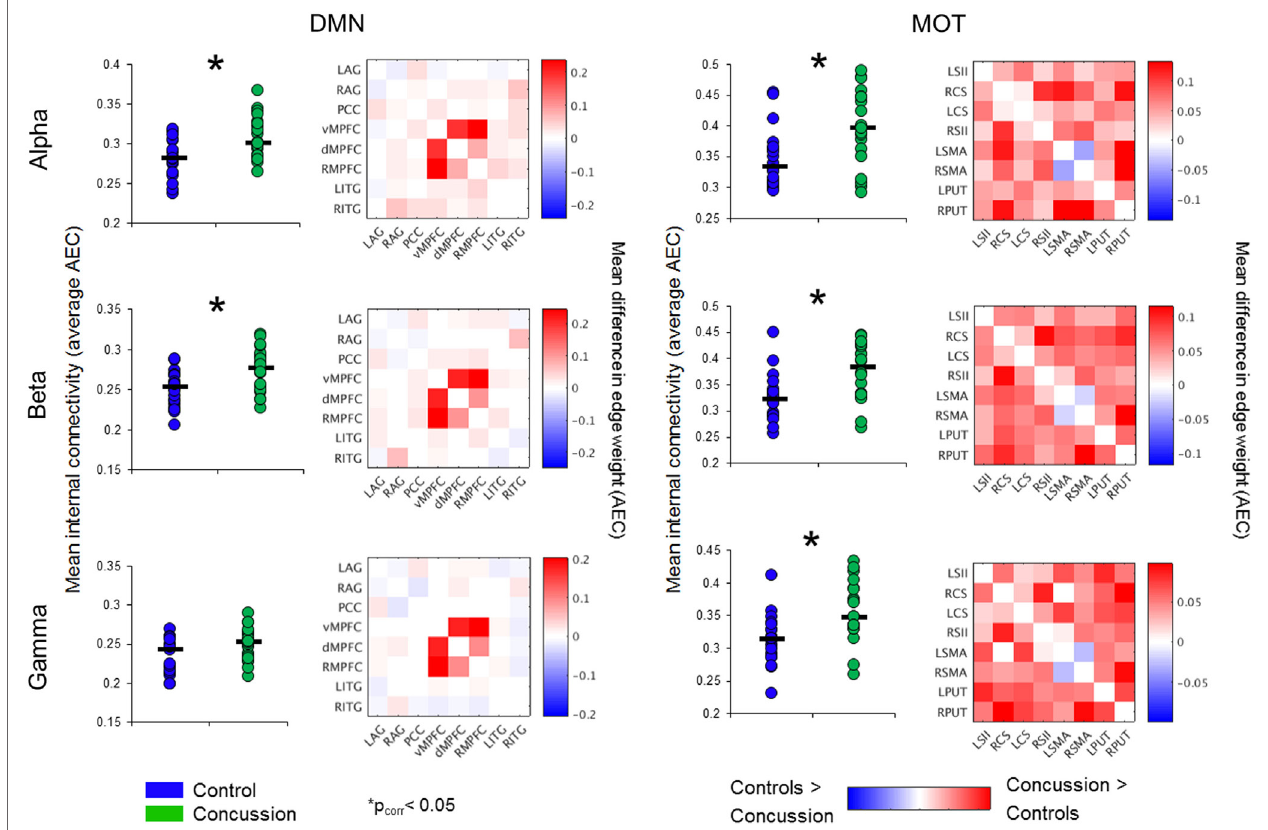
FigUre 2 | Intrinsic connectivity network spectral power content, averaged over node regions that comprise a network. Mean whole-network spectral power content with ± 1 SE bars for the concussion (green) and control groups (blue). Of note is the 10 Hz alpha peak, prominent in the VIS. Abbreviations: DAN, dorsal attention network; VAN, ventral attention network; MOT, motor network; DMN, default mode network, VIS, visual